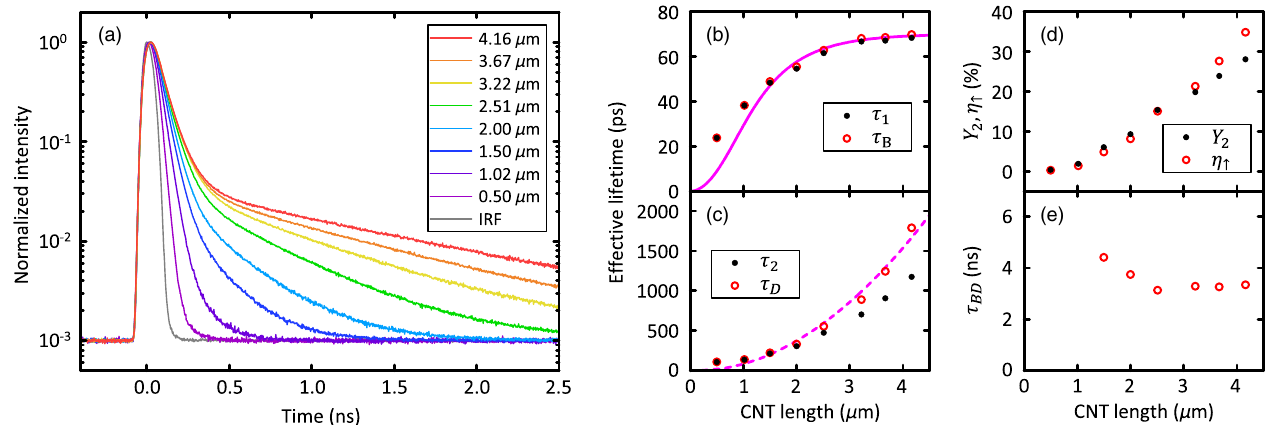
FIG. 2. (a) PL decay curved measured from (9,8) nanotubes with various lengths ranging from 0.5 to 4 . 2 μ m. The gray line is the IRF. P ¼ 5 nW and laser polarization parallel to the CNTaxis are used. (b) Length dependence of τ 1 (filled circles) and τ solid line is the fit with Eq. (4). (c) Length dependence of τ 2 (filled circles) and τ (d) Length dependence of Y 2 (filled circles) and η ↑ (open circles). (e) Length dependence of τ L ≤ 1 . 3 μ m are excluded from the